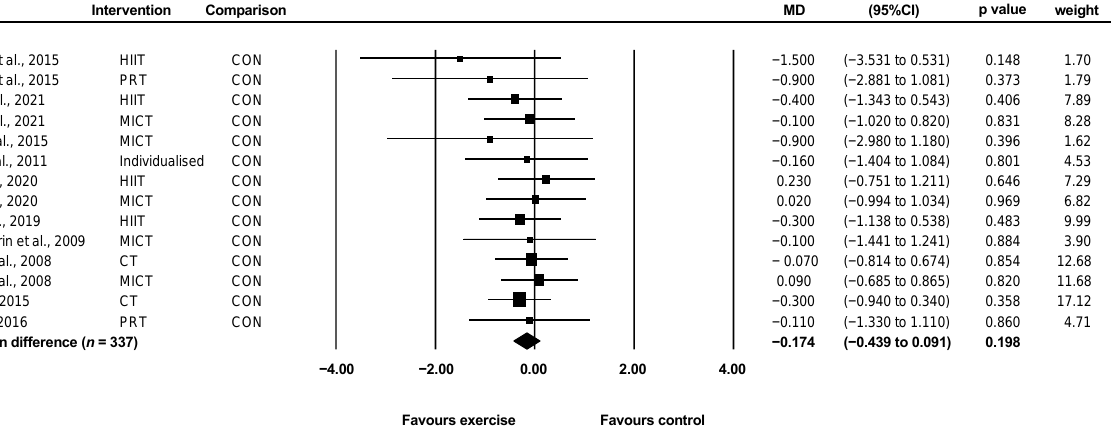
Figure 5. Effect of exercise vs. control for change in HOMA-IR. CI: confidence interval, CT: concurrent training, HIIT: high-intensity interval training, MICT: moderate-intensity continuous training, MD: mean difference, PRT: progressive resistance training.